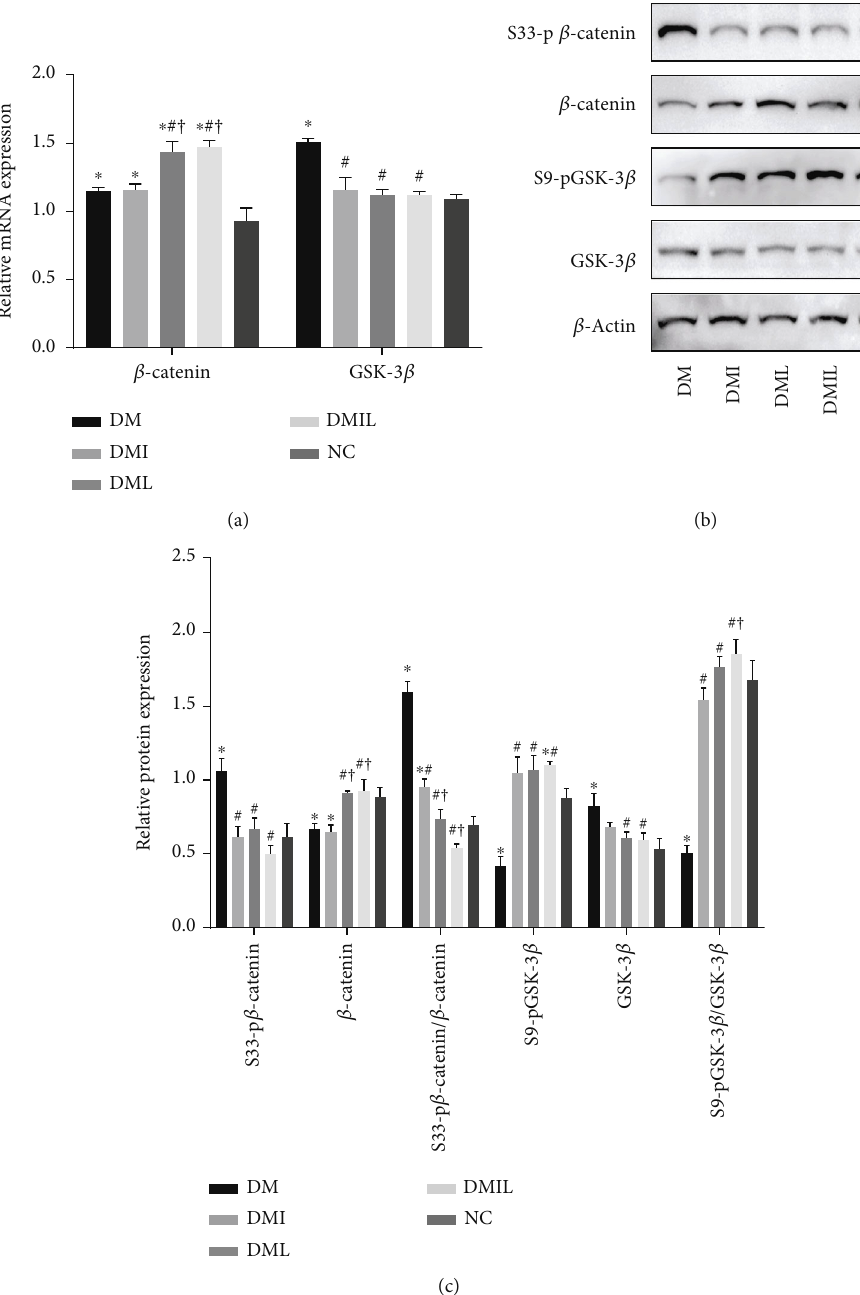
Figure 5: E ff ects of liraglutide on Wnt/ β -catenin pathway activity in DM mice. (a) Relative mRNA expression and quanti fi cation of Wnt/ β - catenin signaling pathway-related molecules. (b, c) Protein bands and relative protein expression of Wnt/ β -catenin signaling pathway- related molecules were detected by Western blot analysis; β -actin was included as a reference for normalization. Data are expressed as mean ± SD ( n = 4 /group); p < 0 : 05 was de fi ned as statistically signi fi cant. DM: saline-treated type 1 diabetes group; DMI: insulin treatment group; DML: liraglutide treatment group; DMIL: insulin+liraglutide treatment group; NC: normal glucose tolerance group; ∗ : compared to NC; #: compared to DM; † : compared to DMI; ‡ : compared to